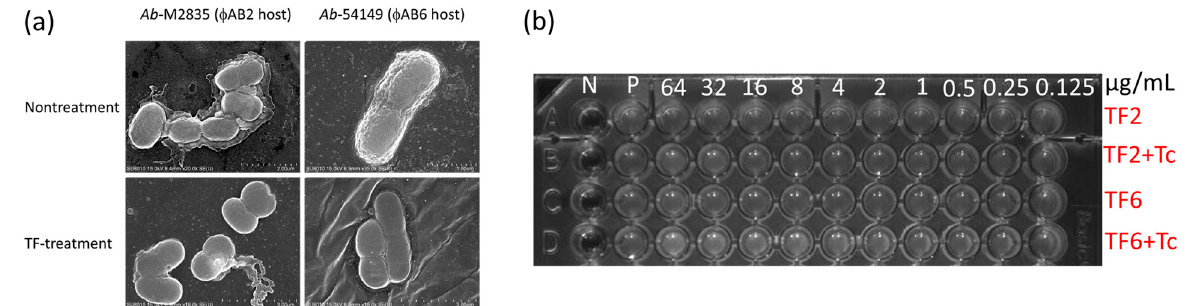
Figure 1. Scanning Electron Microscope (SEM) pictures and antibiotic susceptible test results of tail fiber (TF) treated bacteria. ( a ) The bacterial hosts for phageAB2 and phageAB6 were treated using the corresponding TF proteins. The effective treatment showed a significant morphological change under SEM observation. ( b ) Test of tetracycline susceptibility shows that TF treatment does not alter drug-resistance. Various concentrations of TF were marked on the 96-well dish, with 10 µ g/mL tetracycline used as culture